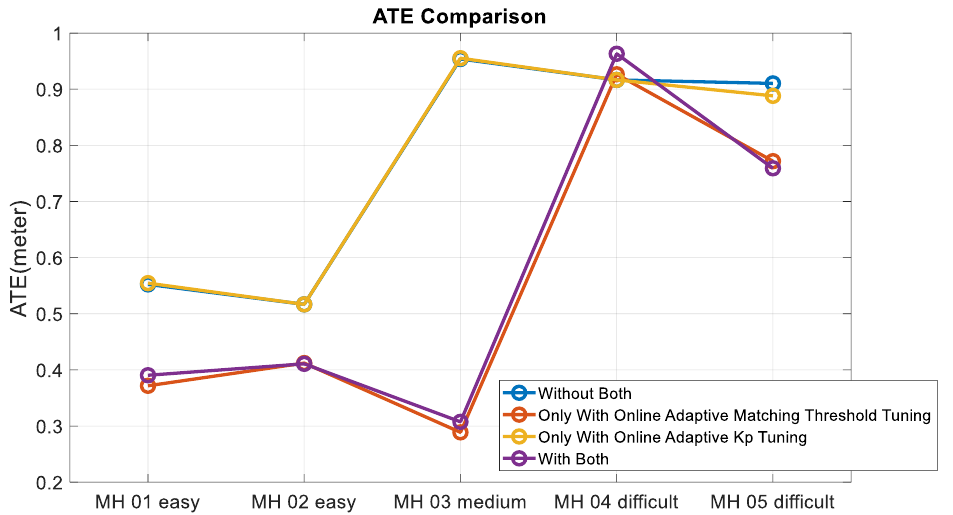
Figure 22. ATE comparison.